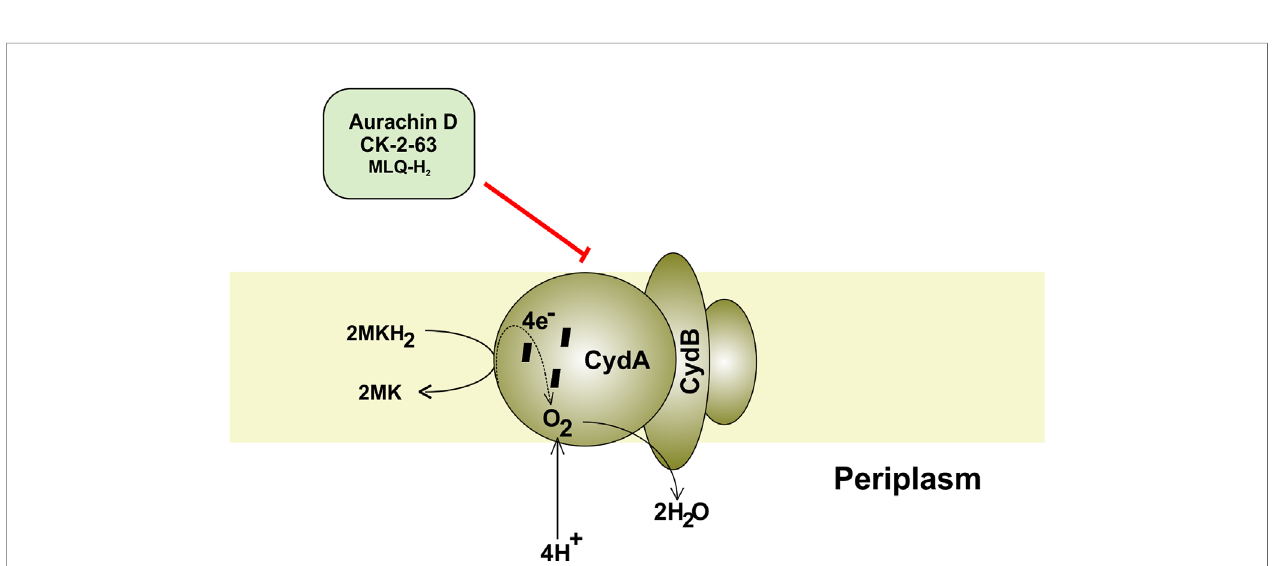
FIGURE 4 | Mycobacterial cytochrome bd oxidase. The components and inhibitors of terminal oxidase cytochrome bd and the passage of electron through its various subcomponents. The electron is fi nally accepted by oxygen, which accepts proton from the periplasm to form